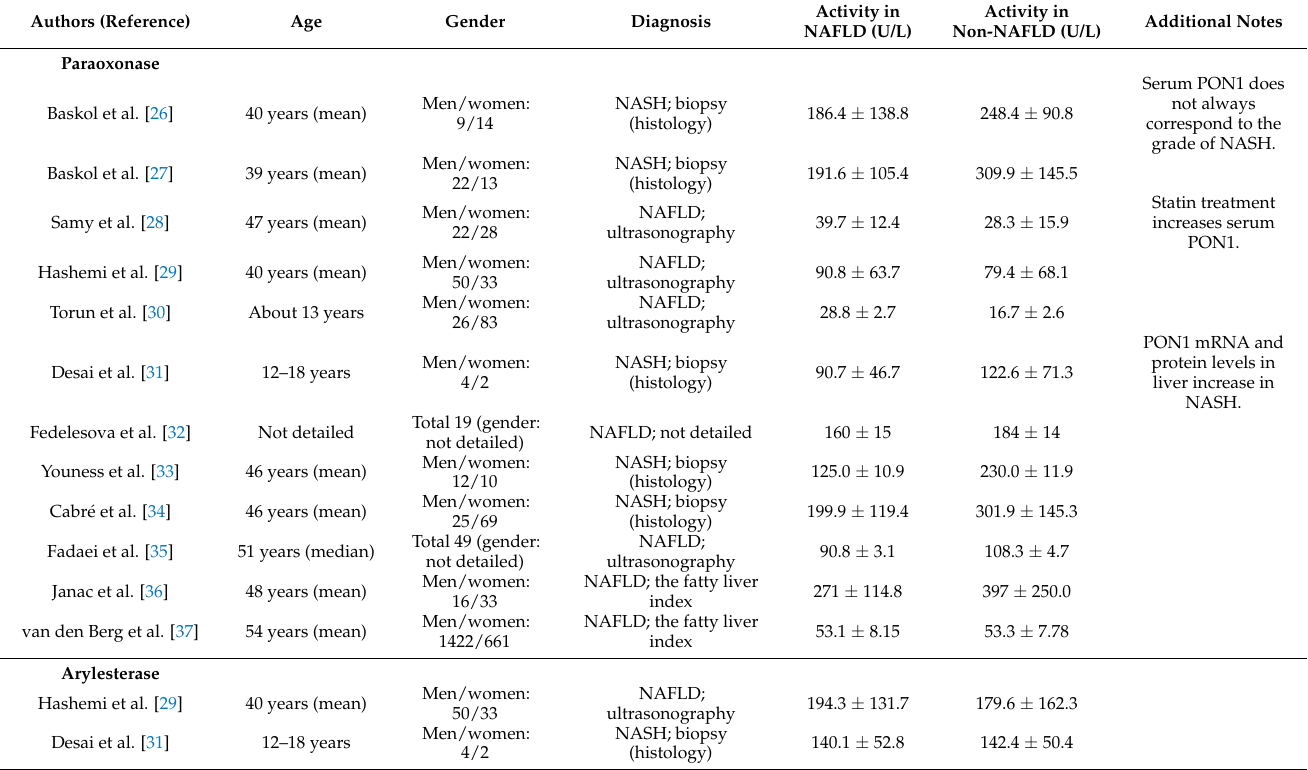
Table 1. Summary of the reviewed articles on NAFLD, including NASH, that investigated the PON1 activity. Age Gender Diagnosis Activity in NAFLD (U/L) Activity in Non-NAFLD